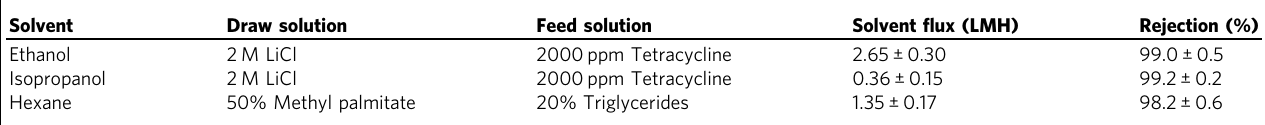
Table 3 Membrane rejection in different solvent systems